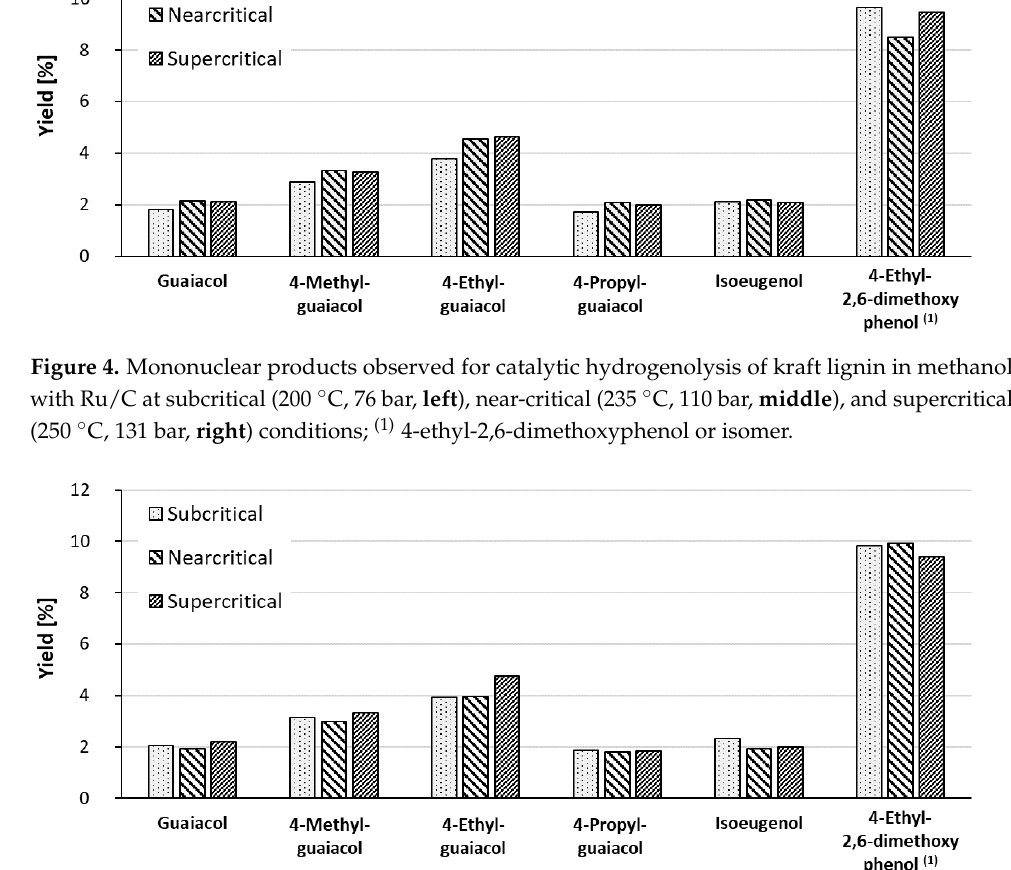
Figure 4. Mononuclear products observed for catalytic hydrogenolysis of kraft lignin in methanol with Ru/C at subcritical (200 °C, 76 bar, left ), near-critical (235 °C, 110 bar, middle ), and supercritical (250 °C, 131 bar, right ) conditions; (1) 4-ethyl-2,6-dimethoxyphenol or isomer.